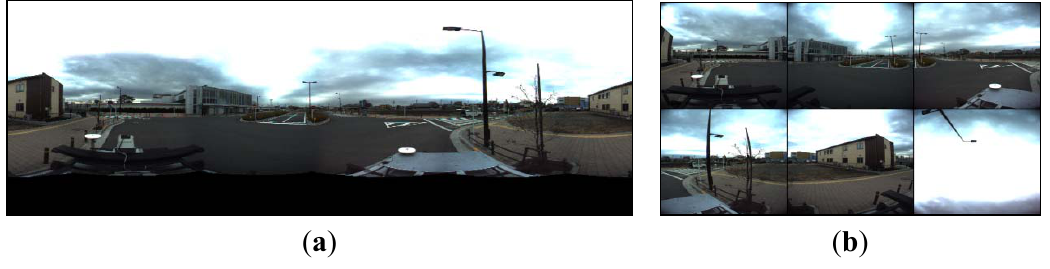
Figure 5. Panoramic image and separate images captured by the Ladybug system. ( a ) Panoramic image. ( b ) Images from 6 separate fish-eye lenses. The image aimed at the sky is not used in our SLAM.